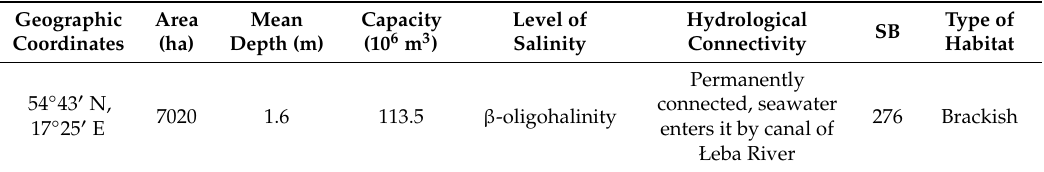
Table 1. Morphometric characteristics and classification of Lake Łebsko. Water body type corresponds to its hydrological connectivity (water exchange with the sea) and level of salinity [6,18]. Geographic Area Mean Capacity Level of SB Coordinates (ha) Depth (m) (10 6 m 3 ) Salinity Permanently connected, seawater β -oligohalinity 276 Brackish enters it by canal of Łeba River SB = average number of days of seawater backflow in 2000–2015